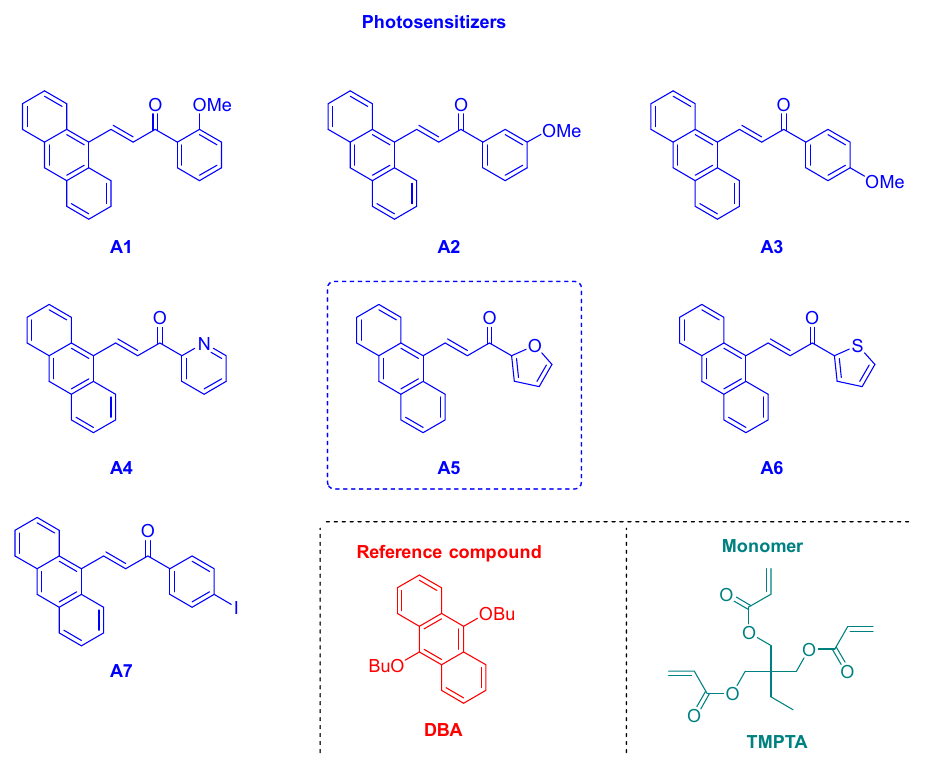
Figure 15. Chemical structures of A1–A7 and DBA.